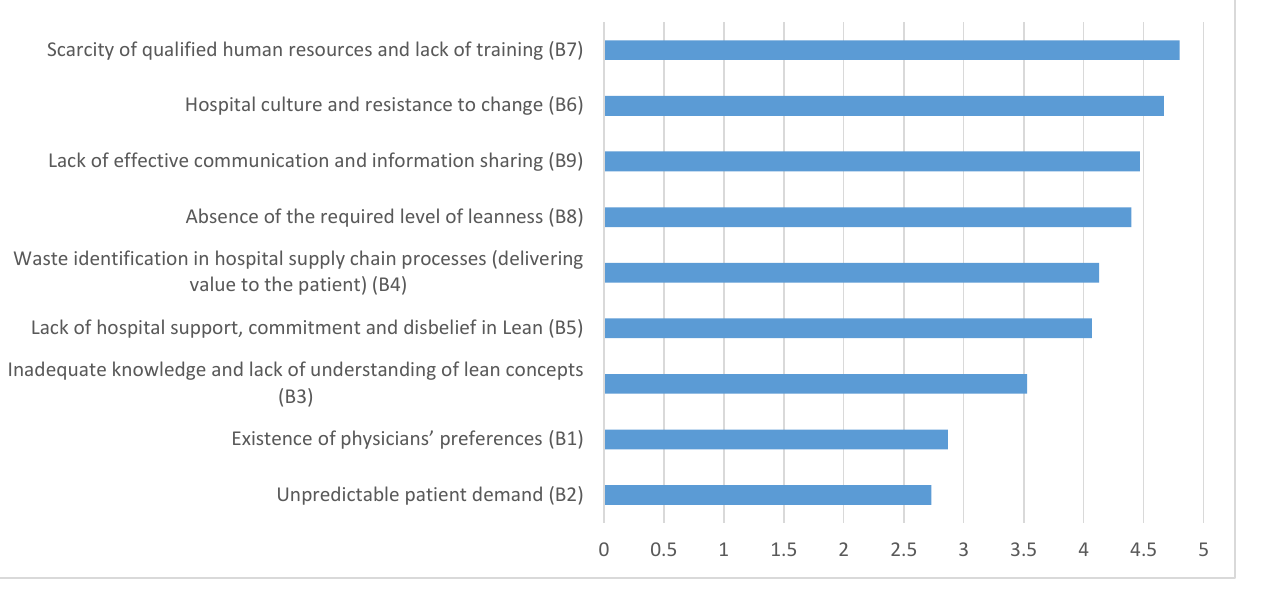
Figure 4. Relevant importance of lean barriers.